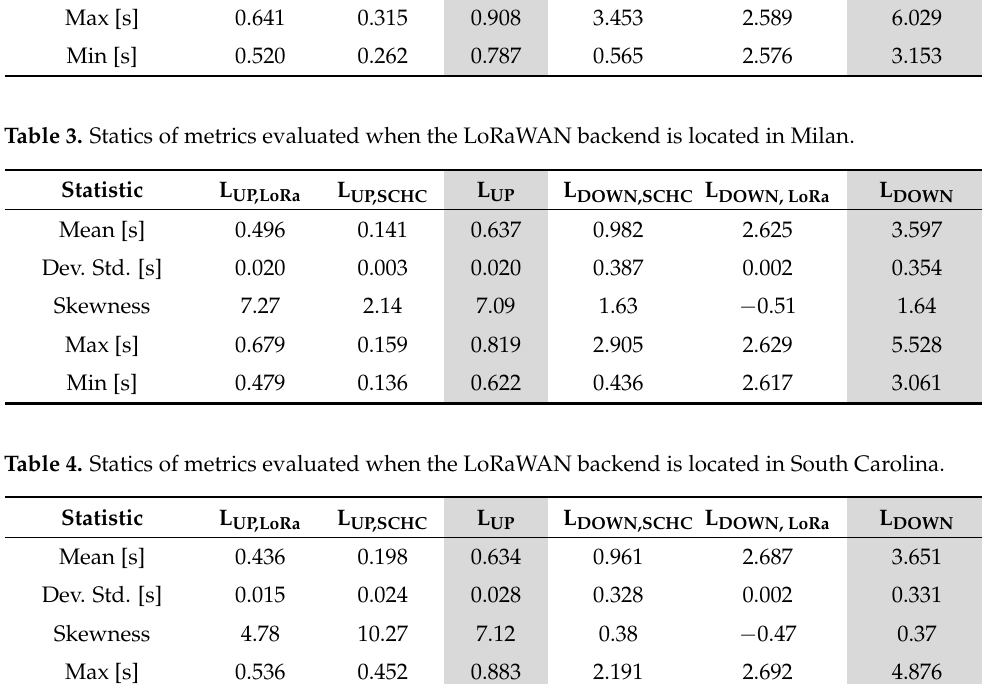
Table 2. Statics of metrics evaluated when the LoRaWAN backend is located in Hong Kong. Statistic L UP,LoRa L UP,SCHC L UP L DOWN,SCHC L DOWN, LoRa L DOWN Mean [s] 0.537